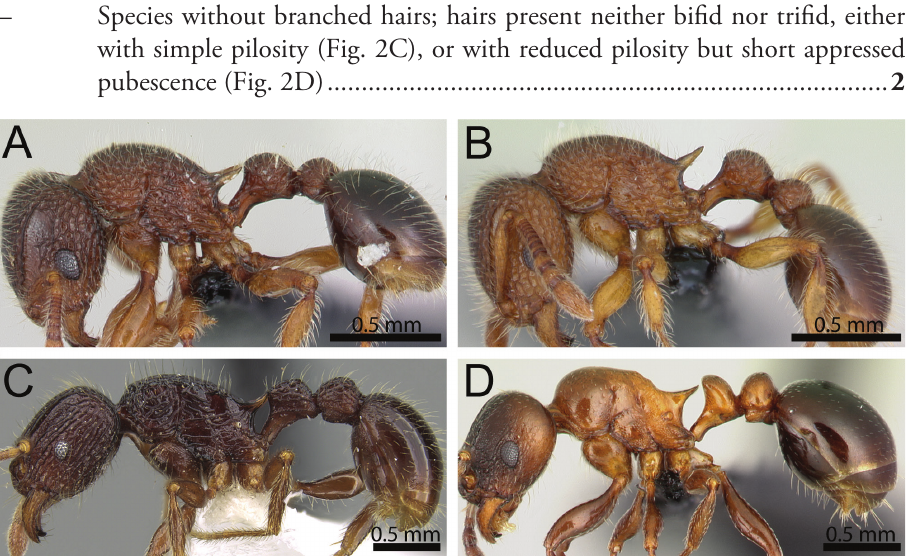
Figure 2. Body in profile. A, B T. lanuginosum (CASENT0060515; CASENT0125328) C T. singletonae (CASENT0247161) D T. wardi (CASENT0475483).